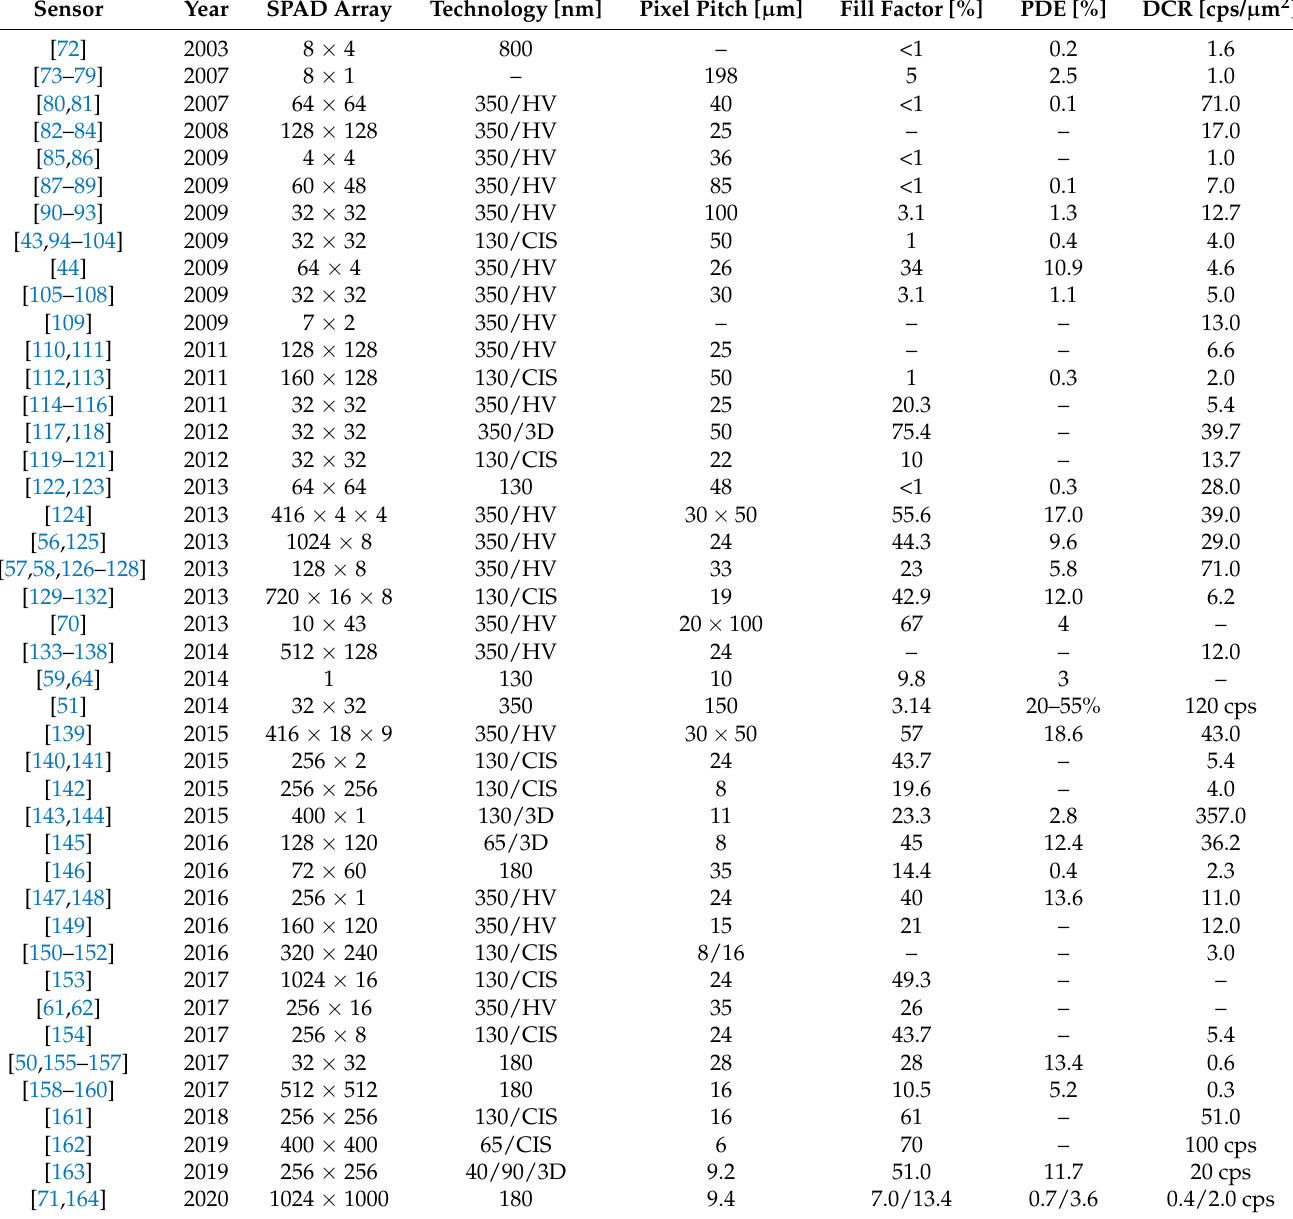
Table 4. SPAD: state of the art, according to [56,59,68,71]. The column Technology reports a number in (nm), and acronyms refer to specific semiconductor manufacturing processes and design rules employed to fabricate each SPAD. HV: high- voltage process; CIS: CMOS imaging sensor process; 3D: 3D integration technology (usually backside illuminated—BSI).